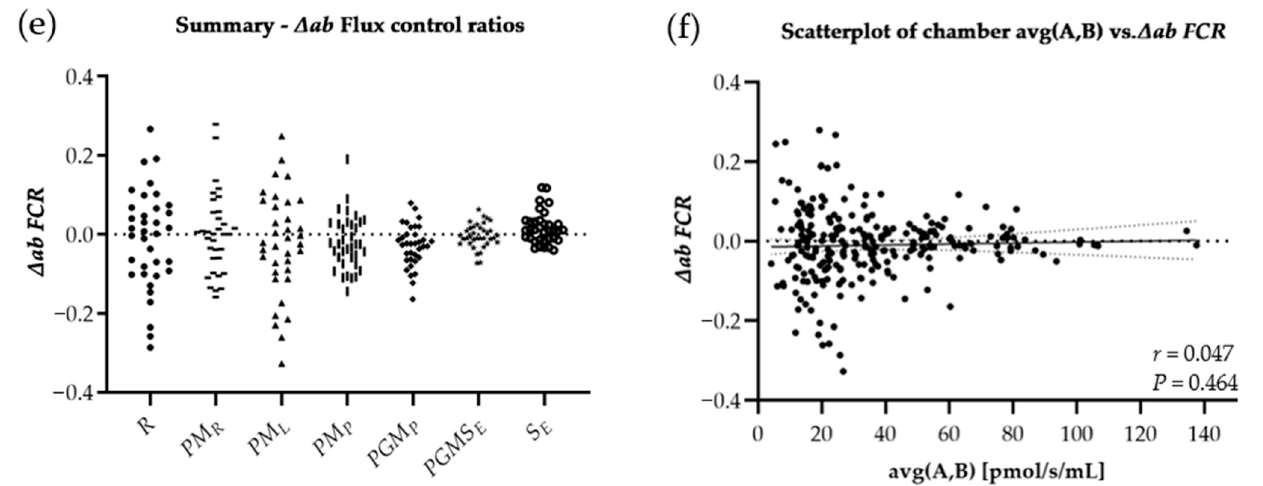
Figure 5. Distribution of variances for FCR : The difference of both chambers A and B, divided by the respective chamber average [ ∆ ab = (A − B)/AVG(A,B)]. Raw data were corrected for ROX and FCR was calculated by normalizing for NS(PGM) P in every single experiment. Graphs show ∆ ab of experiments performed in the laboratory of Oroboros Instruments ( a ), in field conditions before the ultramarathon race ( b ), right after ( c ), and 24 h after individual finish ( d ). ∆ ab for FCR of all experiments (LAB, PRE, POST, REC) are shown in ( e ). ∆ ab for FCR is plotted against average chamber J O2 [pmol/s/mL] to evaluate the dependence of ∆ ab of FCR on J O2 ( f ). The linear trend line and a 95% confidence interval are shown. See Table A1 in the appendix for O2k background correction values and Table A2 for O 2 calibration of each experiment.